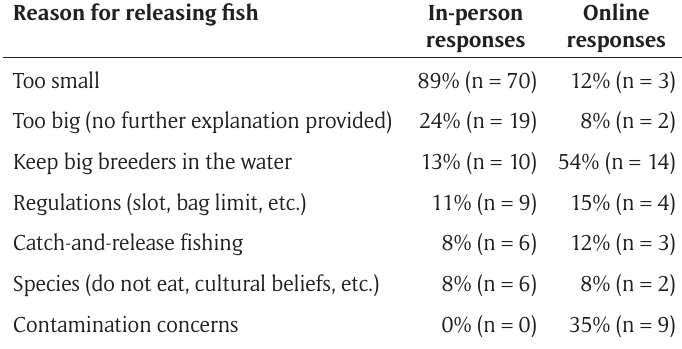
Table 1: Angler reasons for releasing certain fish caught while ice-fishing the SLRE displayed as percent of surveyed anglers to select each response (based on 79 and 26 individuals from in-person and online surveys, respectively), with sum of each response in parentheses. Anglers could provide more than one